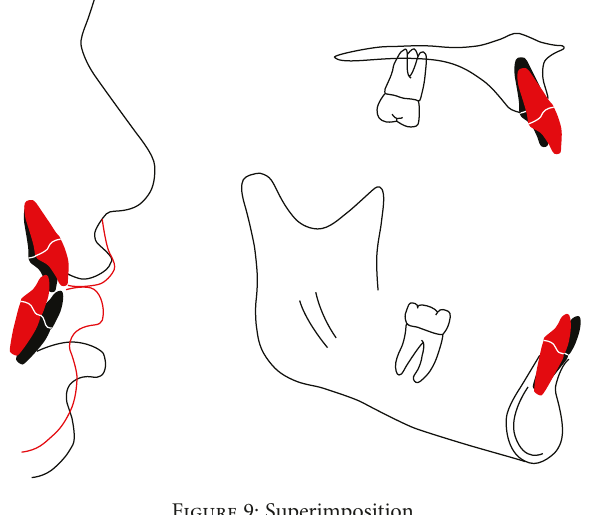
Figure 9: Superimposition. Table 1: Cephalometric measurements.